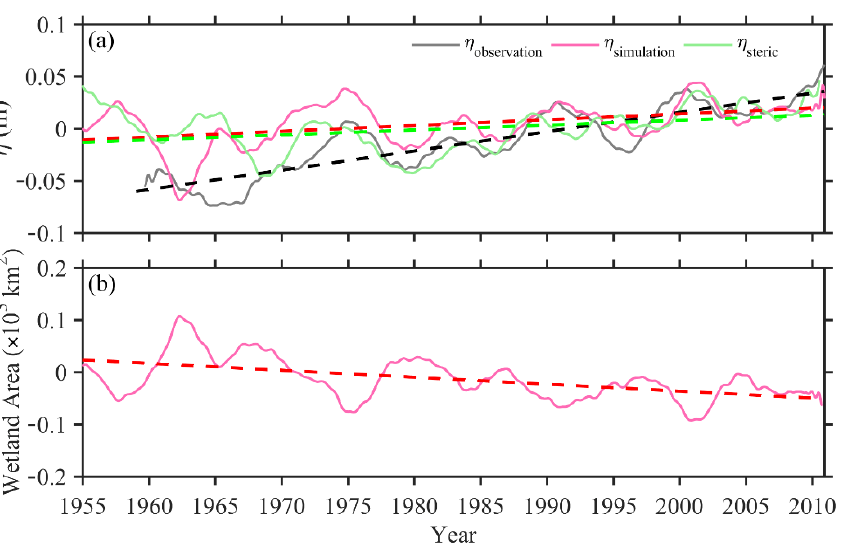
Figure 10. The long-term (>1 year) variations of ( a ) the observed, simulated, and steric sea surface height anomalies at Lvsi tidal gauge, and ( b ) the wetland area. The dashed lines with the same color schemes denote the corresponding linear trends.